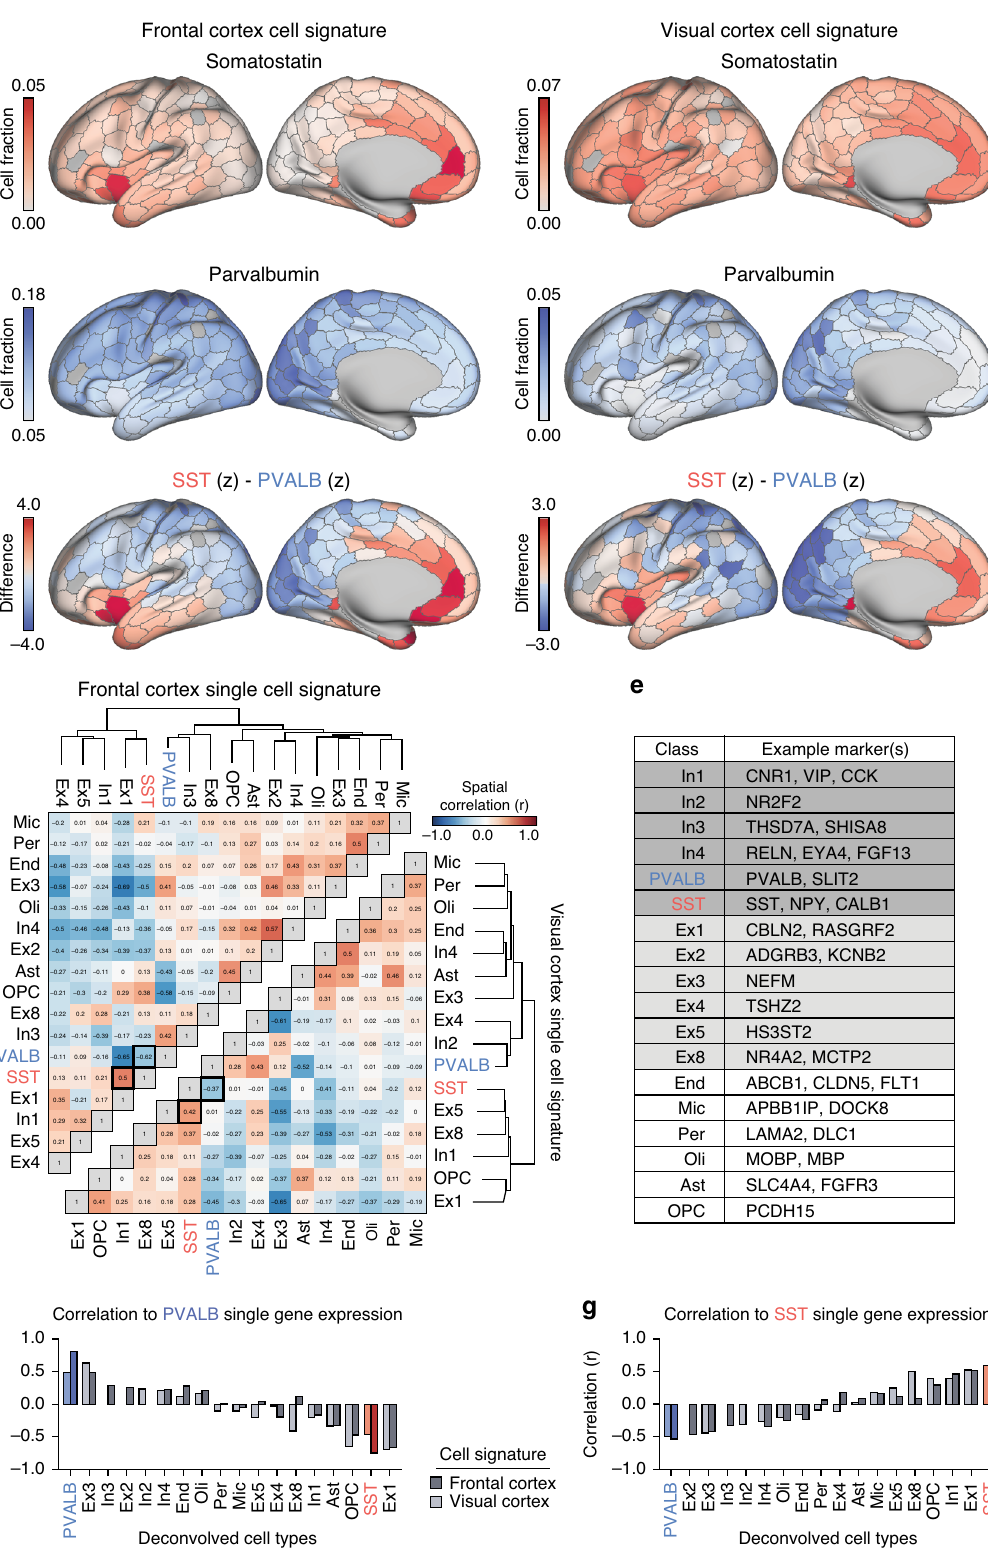
across sub-regions was signi fi cantly positively correlated to ground truth cell density estimates in rodents (Fig. 3b; r s = 0.41, p = 0.025). Results were consistent when Spearman-rank correlation was used to limit the in fl uence of outliers, and when the ratio of SST/PVALB rodent cell densities was used rather than the difference ( r s = 0.49, p =